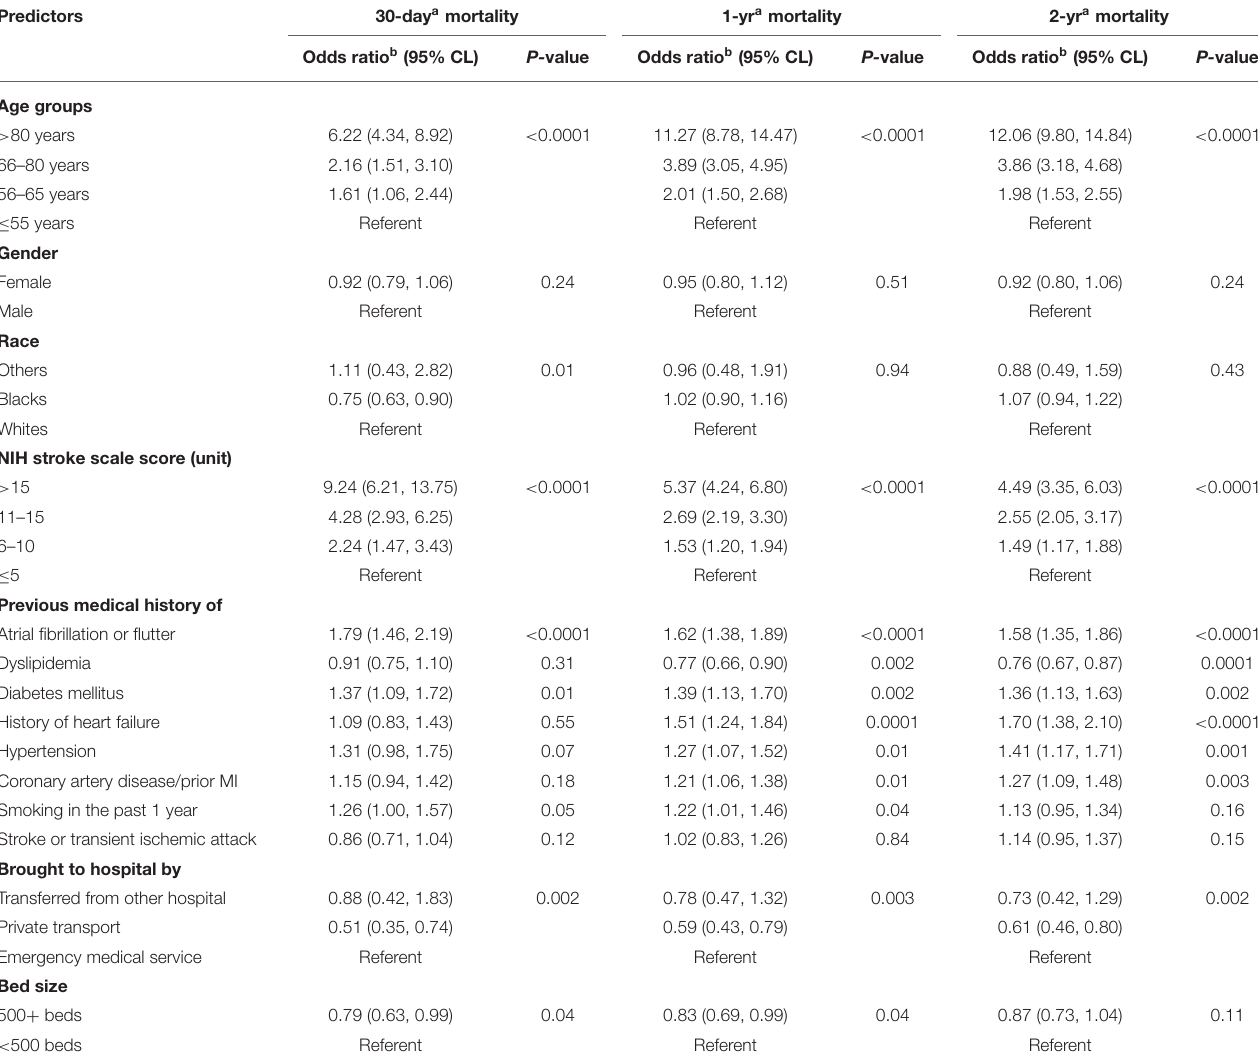
TABLE 2 | Relative risk of mortality among acute ischemic stroke patients treated with intravenous